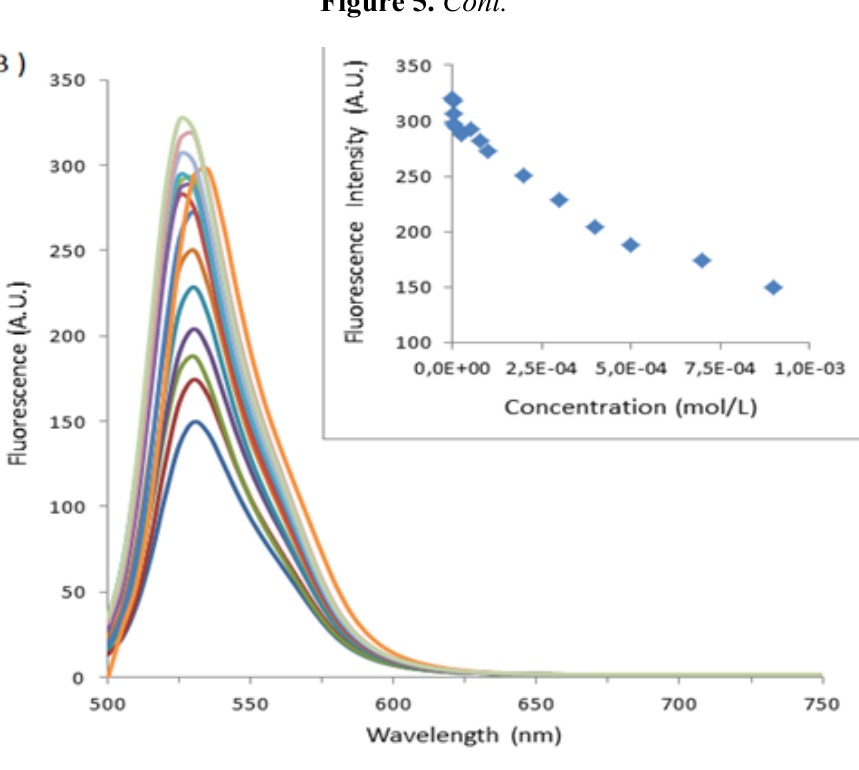
Figure 6. Graph of 1/ Δ If versus 1/[H] for BSA-FITC above ( A ) 1 _Ag_NP, ( B ) 2 _Ag_NP. 0 In the inset, the straight line equation with the coefficient of determination R 2